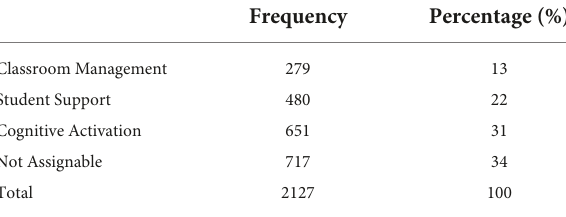
TABLE 6 Frequency table of the identified measurement dimensions crossing three basic dimensions (deductive